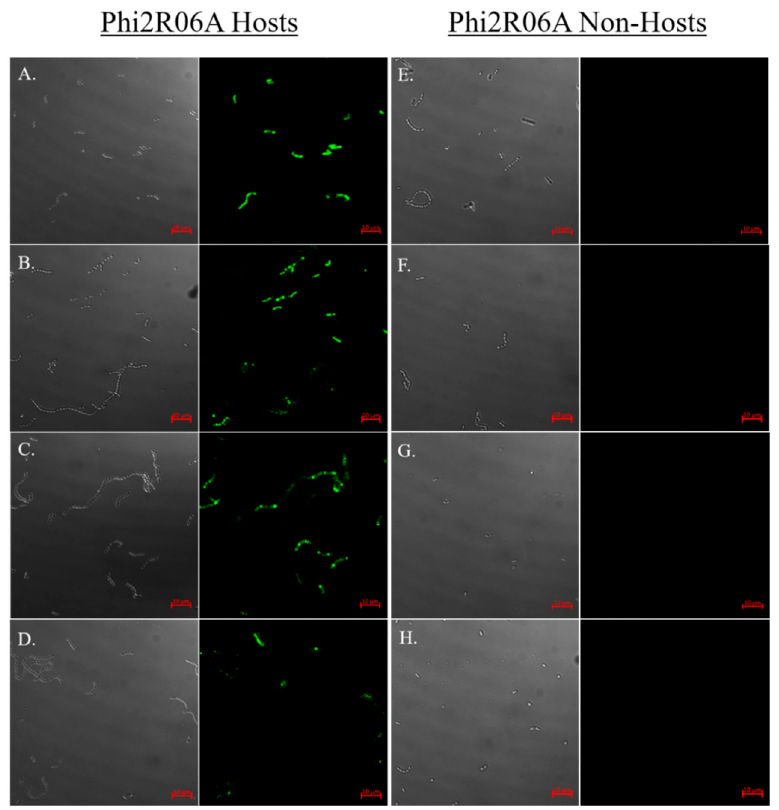
Figure 6. Host binding assay of GFP-labelled TpeX of the MTP of Phi2R06A against eight strains: four hosts which the mature phage is capable of infecting ( A – D ), and four non-host strains ( E – H ). Binding to host strain L. lactis 2 (CWPS Type B; panel A ), host strain L. lactis 10 (CWPS Type B; panel B ), host strain L. lactis 17 (CWPS Type B; panel C ), host strain L. lactis 3 (CWPS Type Unknown; panel D ), non-host strain L. lactis C (CWPS Type A; panel E ), non-host strain L. lactis 4 (CWPS Type C; panel F ), non-host strain L. lactis 13 (CWPS Type C; panel G ), non-host strain L. lactis A (CWPS Type Unknown, panel H ). MTP was added at a quantity of 25 µg. Cells were visualised using differential interference contrast (DIC) microscopy (panels on the left), and fluorescent confocal microscopy (panels on the right) at wavelength of 488 nm. Scale bars correspond to 10 µm.